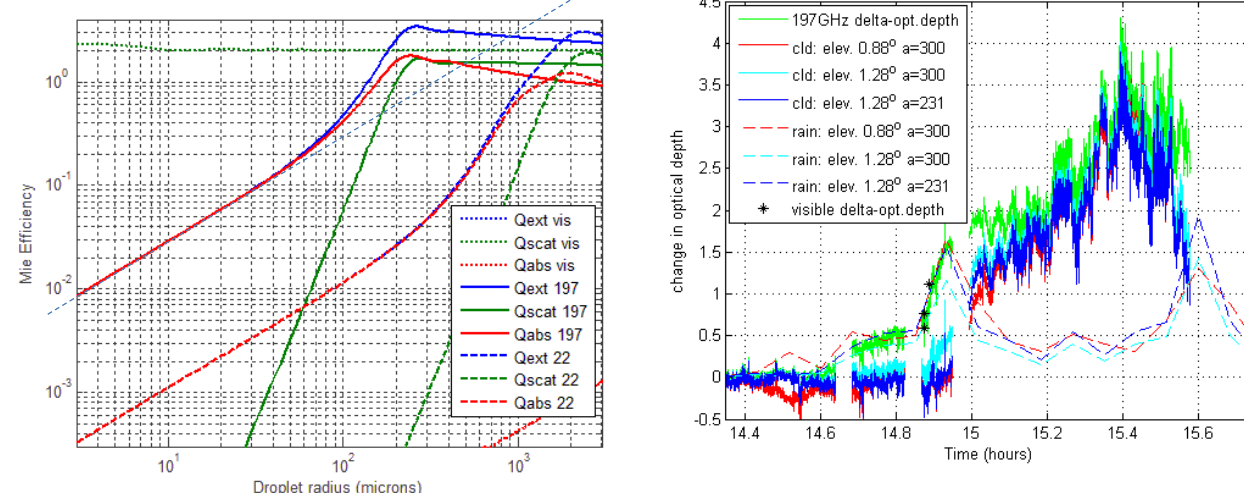
Fig. 17. Plots of the change in optical depth during the storm. Green is the change in optical depth measured at 197GHz. The optical depths due to rain estimated from the WSR-88 radar are shown as dashed lines. The estimated optical depths due to clouds are shown as solid red, cyan and blue lines, which are calculated as the dif- ference between the 197GHz measurements and that due to rain. The asterisks are changes in optical depth at visible wavelengths derived from photographic images taken during the storm. See text for details. Fig. 16 to calculate the expected extinction coefficient and, from that, the expected extinction coefficient of the rain at the ATOMMS